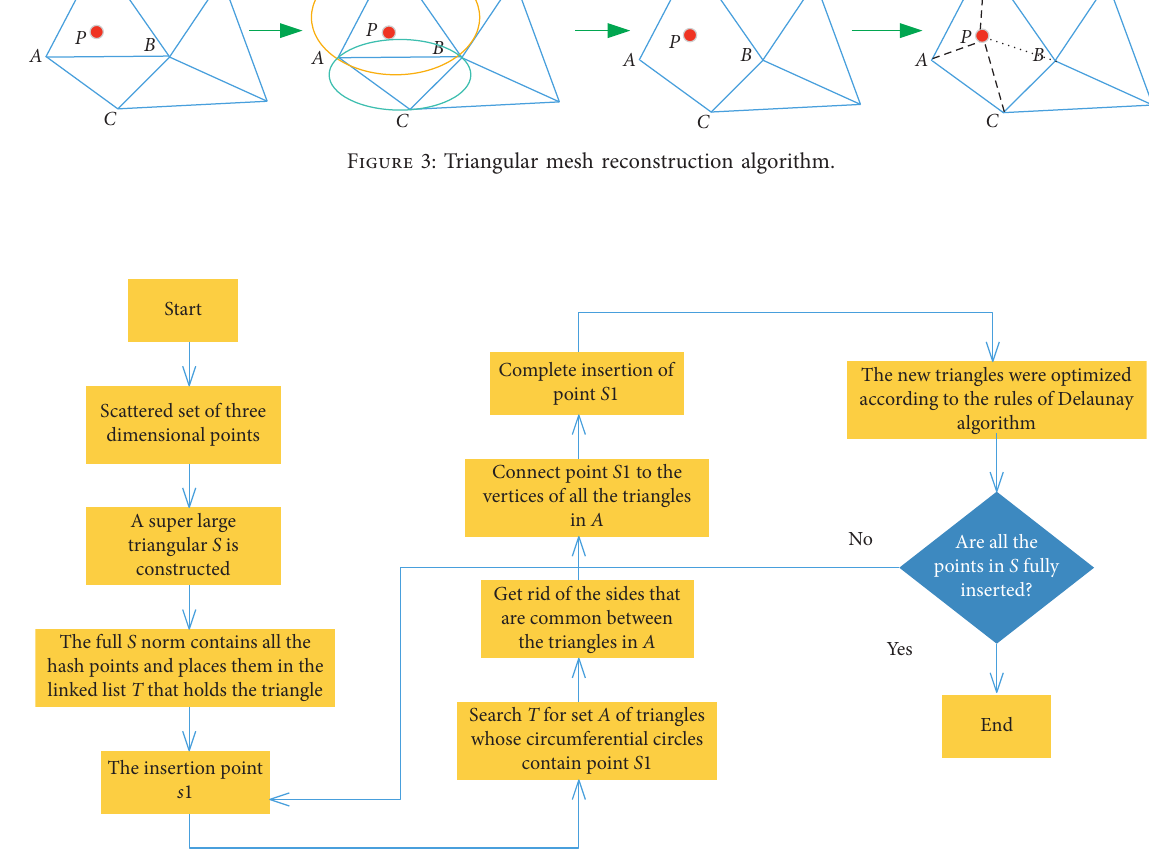
Figure 4: Delaunay point-by-point insertion